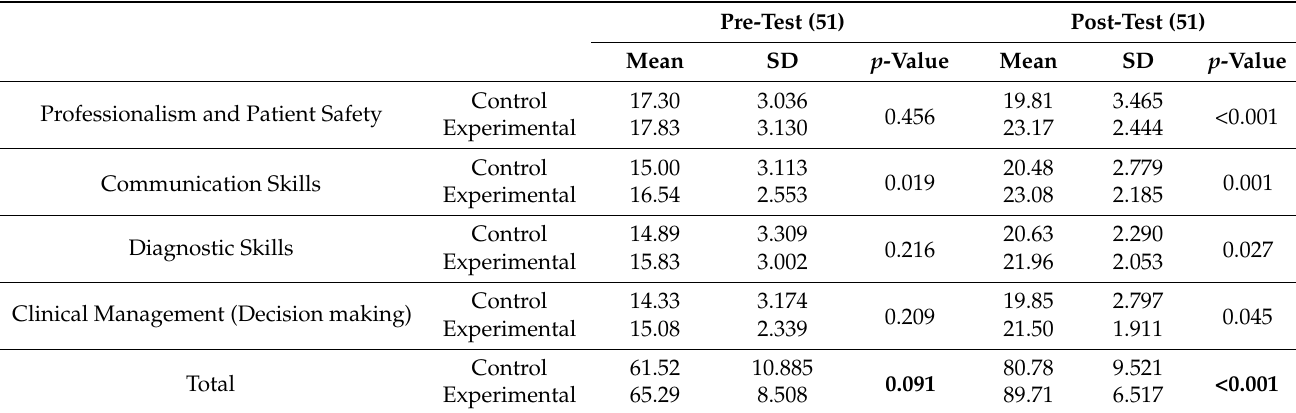
Table 2. Comparisons between control and experimental